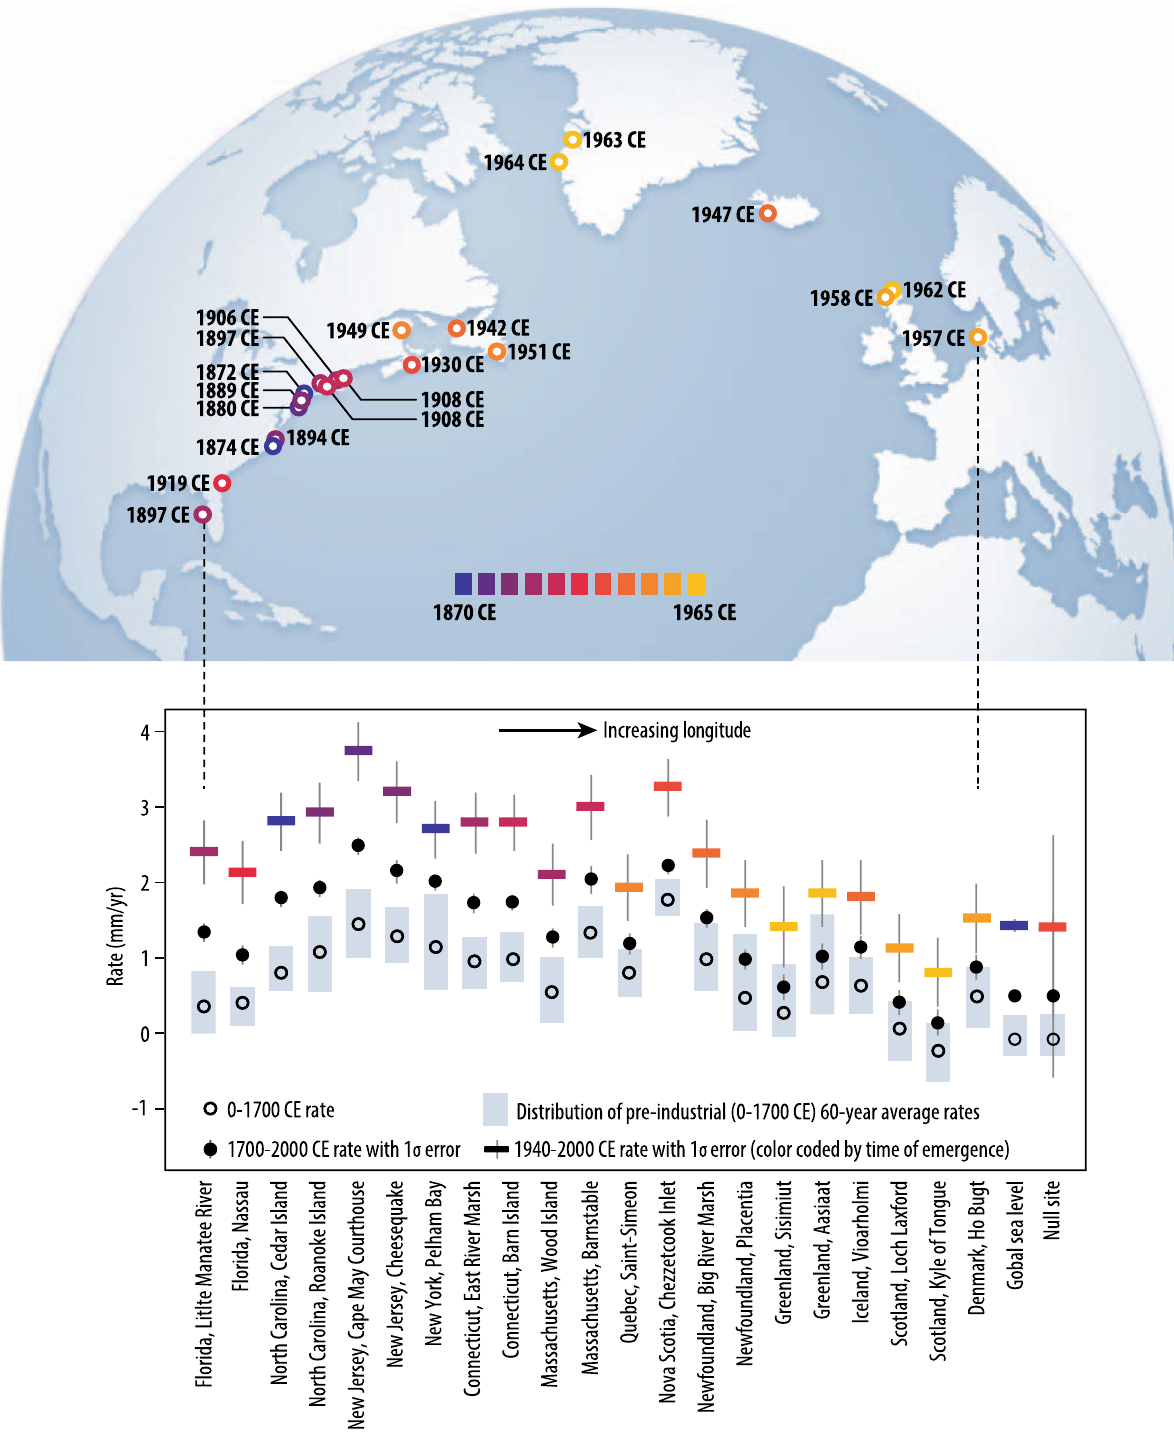
Fig. 2 Spatial variability in the time of emergence of modern rates of relative sea level. Time of emergence is shown for global sea level, null site (indicative generic site in northeast Asia (38°N, 127°E) with no instrumental data and far from available proxy data), and sites in the North Atlantic. Common Era rates for the periods 0 – 1700, 1700 – 2000, and 1940 – 2000 CE, as well as the distribution of mean estimates of pre-industrial 60-year rates, are also shown for each site by increasing